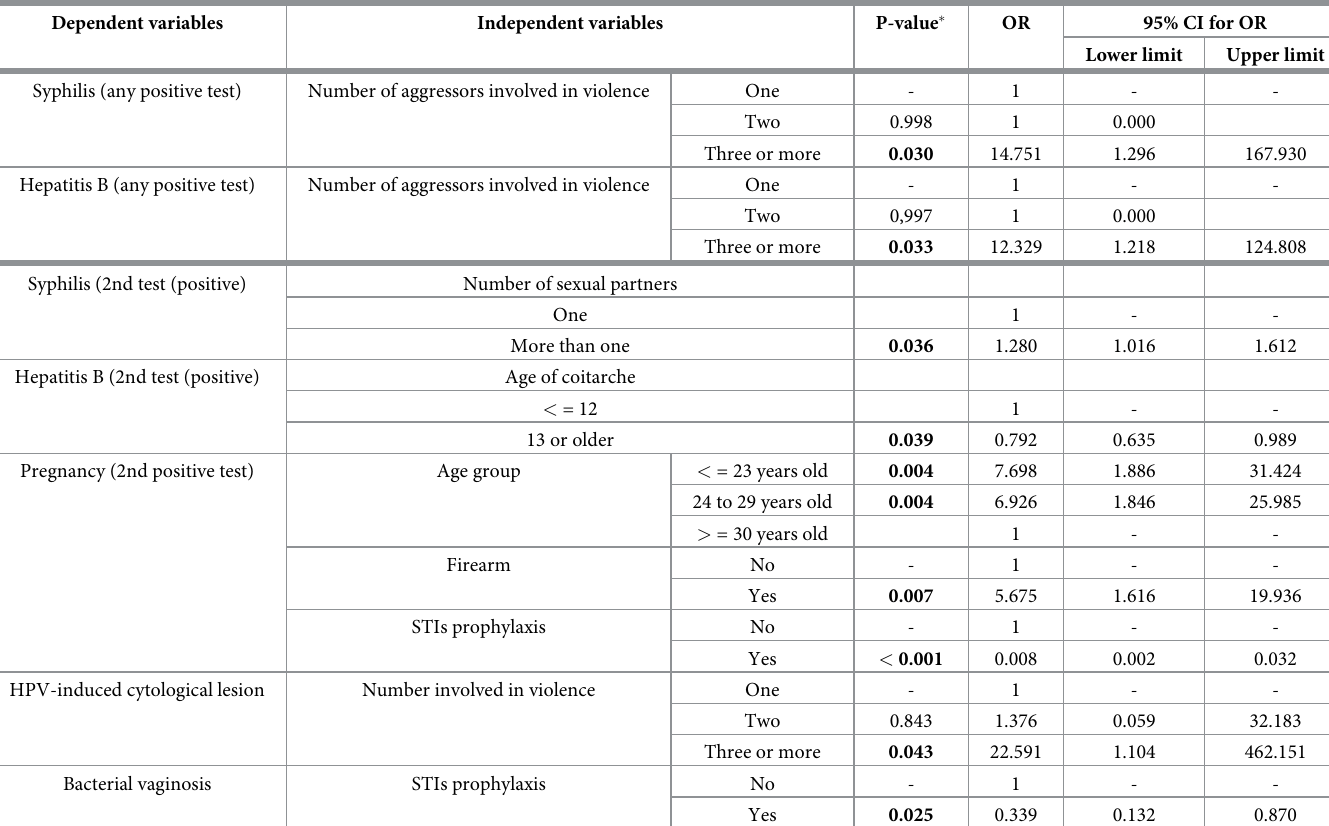
Table 4. Variables associated with blood-borne infections and pregnancy in women in sexual violence situations assisted by PAVI´VIS between 2010 and 2019 (N = 904 ��